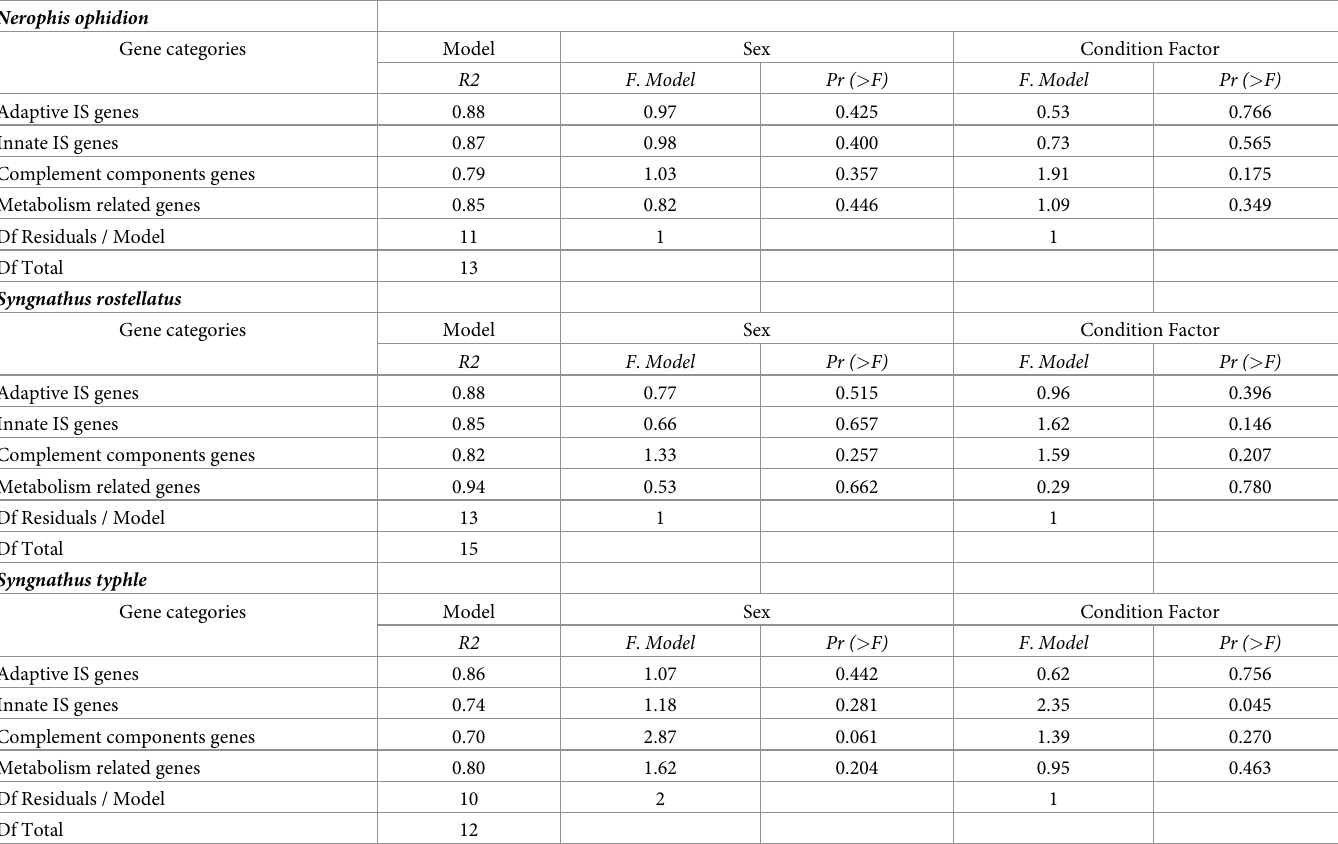
Table 1. Species-specific PERMANCOVA results of candidate gene expression assessing sex differences. A condition factor (K = W/TL 3 ) was included as